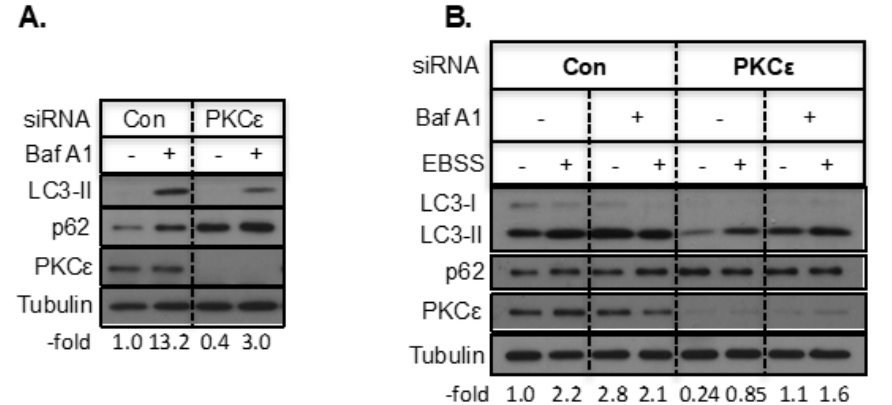
Figure 3. Knockdown of PKC ε inhibited starvation-induced atuophagy. T47D cells transfected with the control or PKC ε siRNA were treated with Baf A1 ( A ) or EBSS in the presence or absence of Baf A1 ( B ). The fold change in LC3-II with respect to control and normalized with loading isindicated below the Figures.